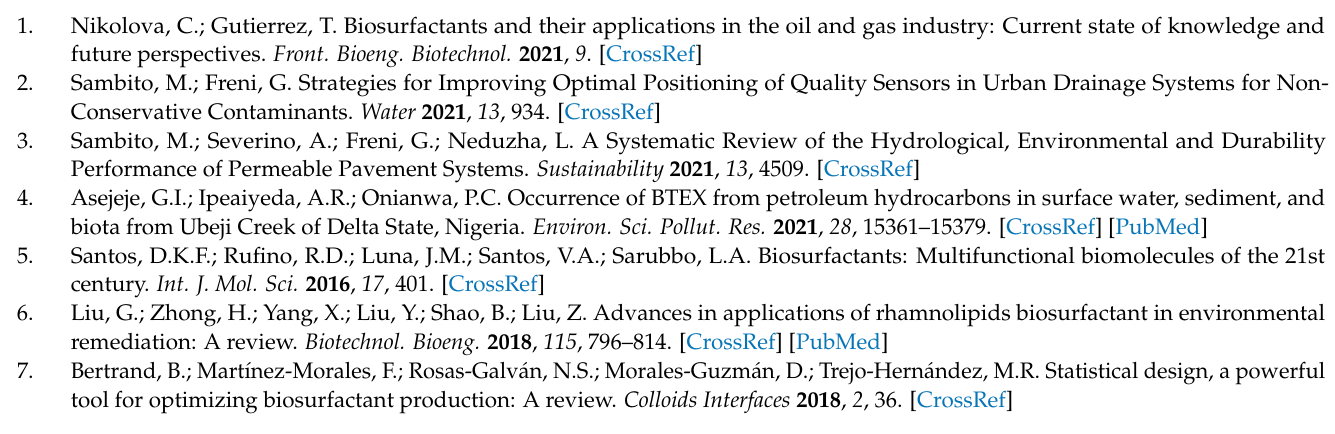
Figure A8. Production scheme of rhamnolipids using a sequencing batch reactor.